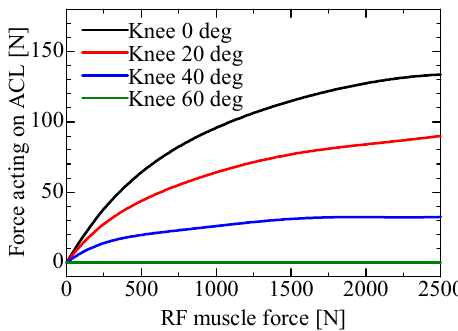
Fig. 4 The relationship between the RF muscle force and force on the